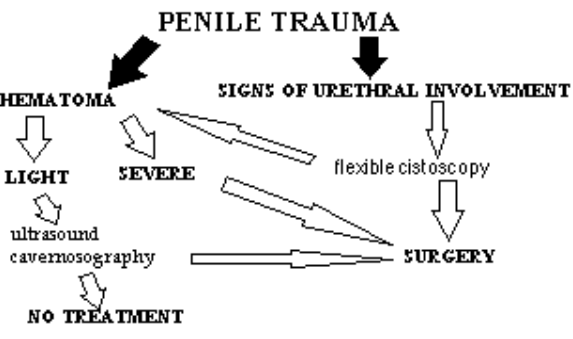
FIGURE 1A. Flow-chart for surgical treatment of penile trauma.